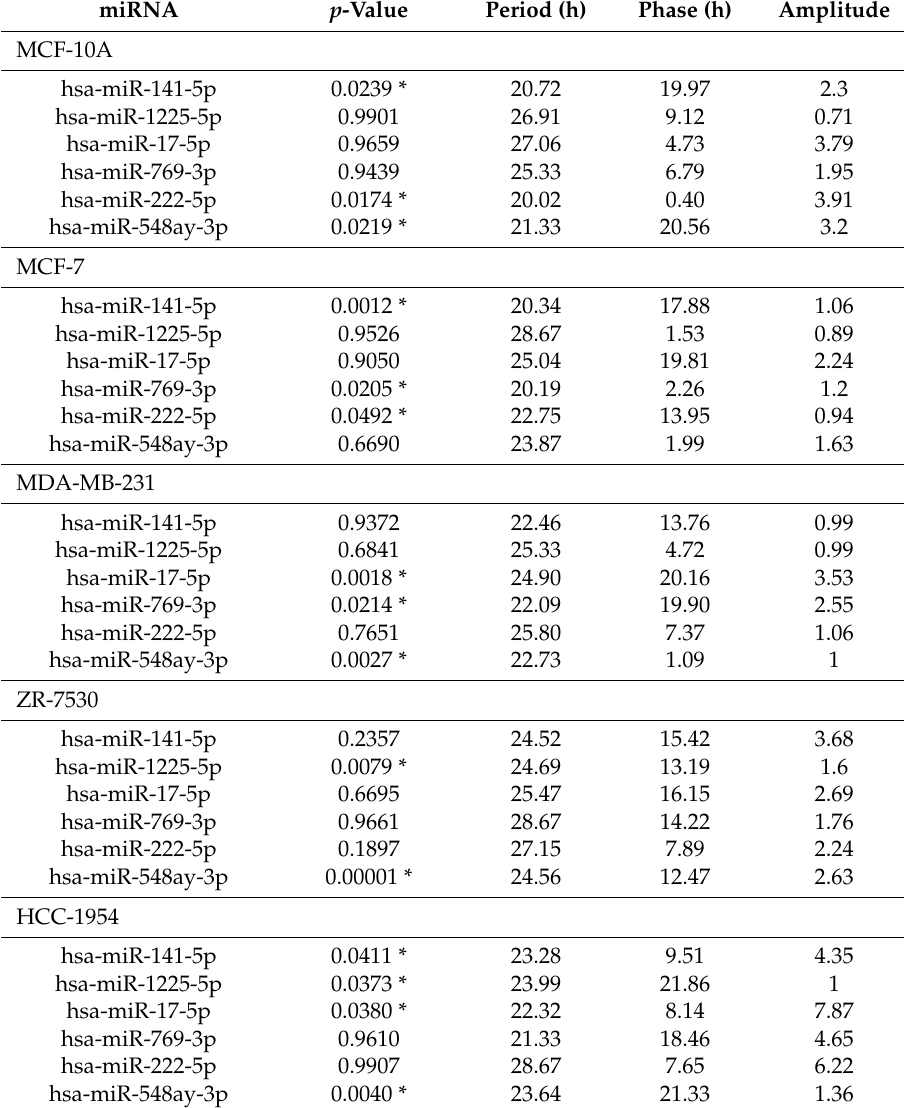
Table 1. Rhythmic features of the miRNA expression profiles obtained over 48 h from the MetaCycle algorithm for non-tumorigenic and tumorigenic breast cell